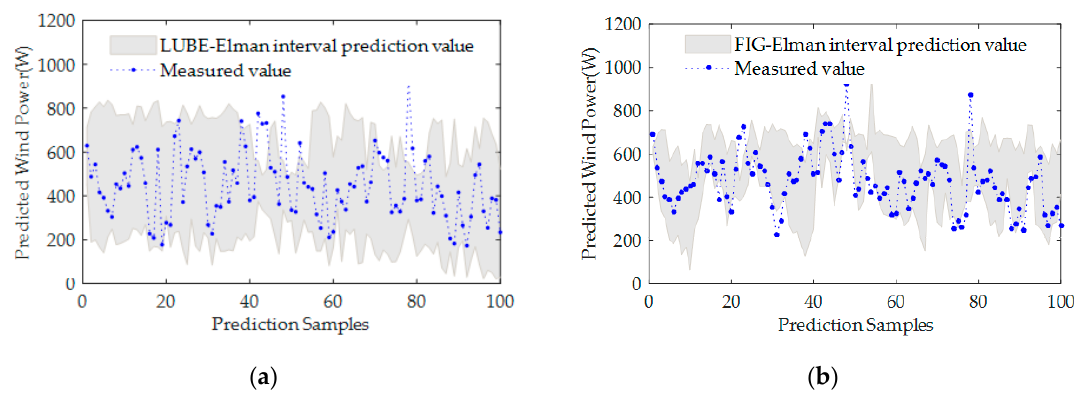
Figure 6. 1500 W Wind Turbine Power Interval Prediction Results. ( a ) 2018.01.30 12:00 a.m.–12:30 a.m. LUBE-Elman forecasting chart; ( b ) 2018.01.30 12:00 a.m.–12:30 a.m. FIG-Elman forecasting chart.